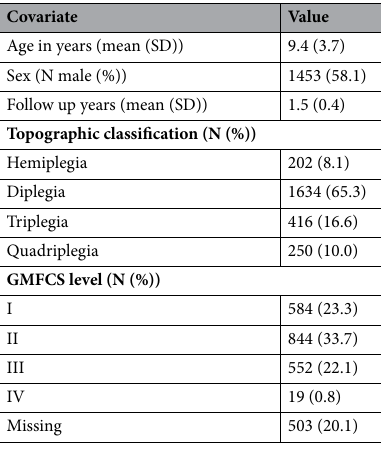
Table 1. Observation (limb) characteristics. Limb is the fundamental unit of observation, so values are reported per limb.